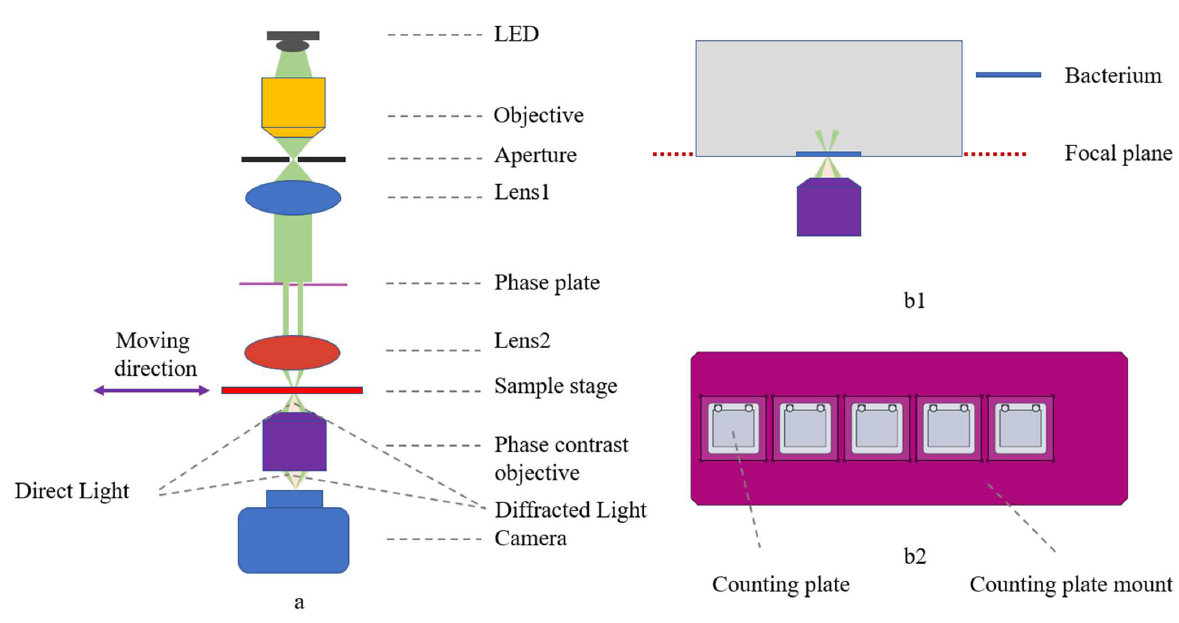
Figure 2. Phase contrast microscope overview. ( a ) Optical layout with ray tracing: direct light in green, diffracted light in orange; ( b1 ) bacteria at the focal plane of the microscope after centrifugation; ( b2 ) counting plate mount with five holes, allowing simultaneous detection of bacterial growth at five different concentrations of antibiotics.